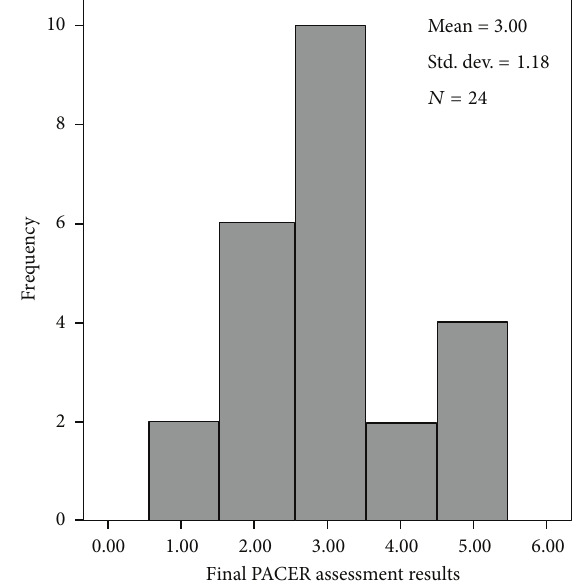
Figure 1: Histogram of initial 20-meter PACER assessment. Fre- quencies are groups by 1 (1–10 laps), 2 (11–20 laps), 3 (21–30 laps), 4 (31–40 laps), and 5 (greater than 40laps).